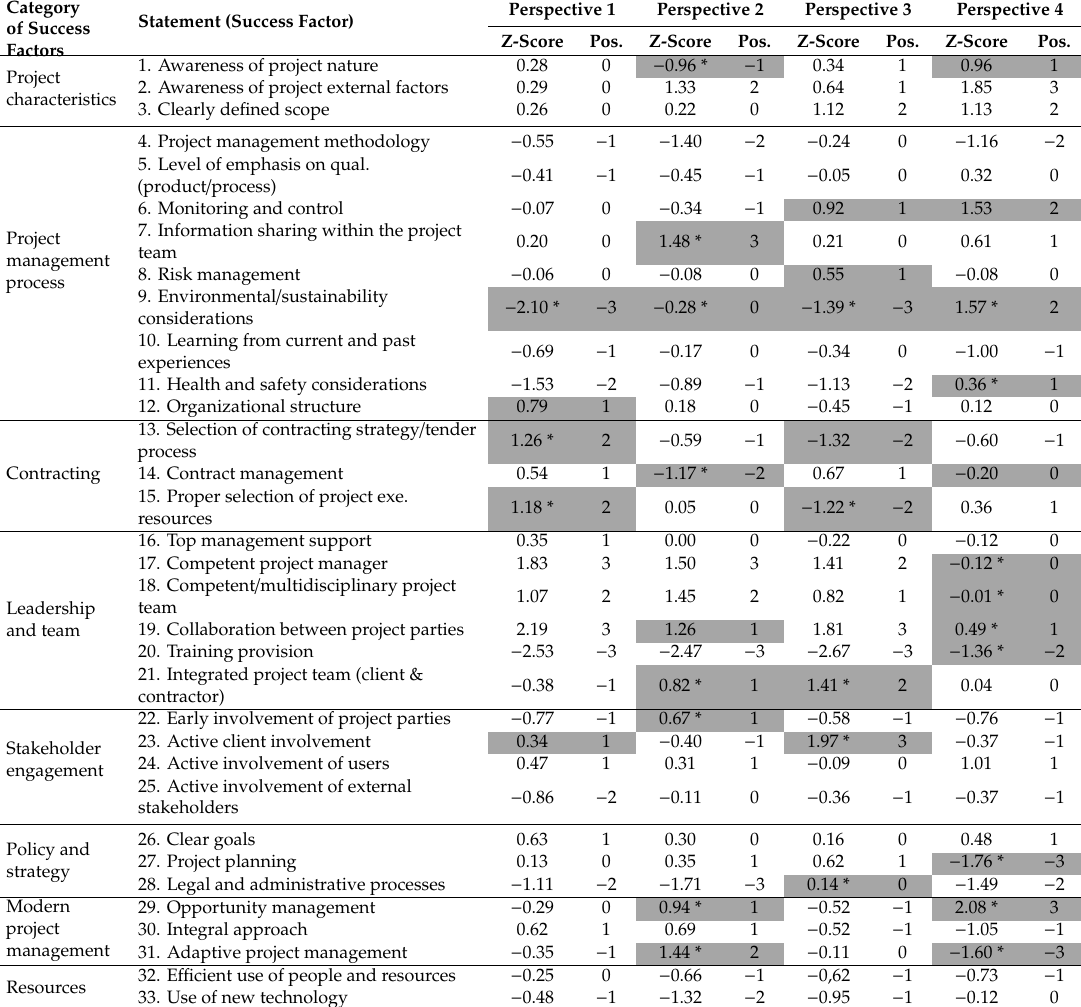
Table A1. Z-scores and corresponding position of success factors in the Q-sorts per perspective.